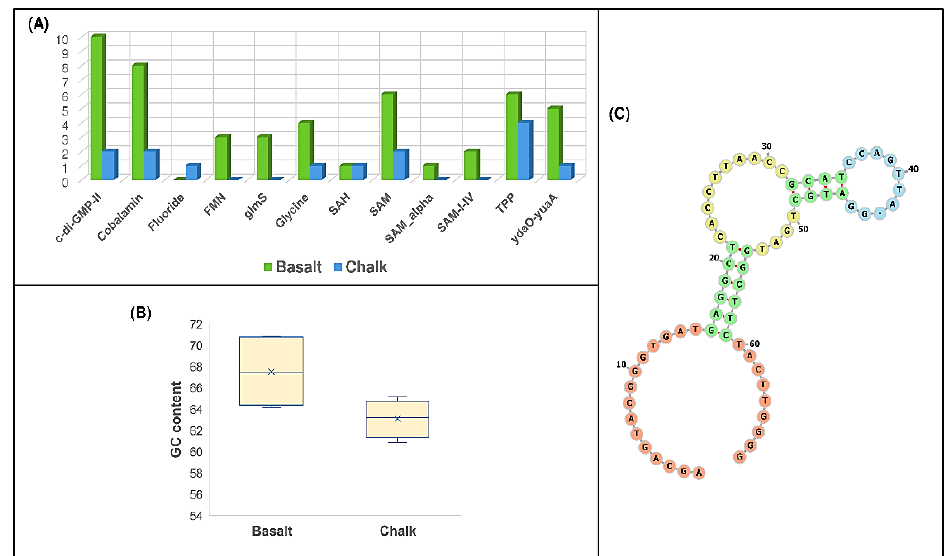
Figure 4. ( A ) Riboswitch distributions in the metagenomic assembled genomes (MAGs) from basalt and chalk samples. ( B ) The differences in GC content in the identified TPP riboswitches between basalt and chalk samples. ( C ) Secondary structure of fluoride sensing riboswitch identified in the MAGs from the chalk sample.